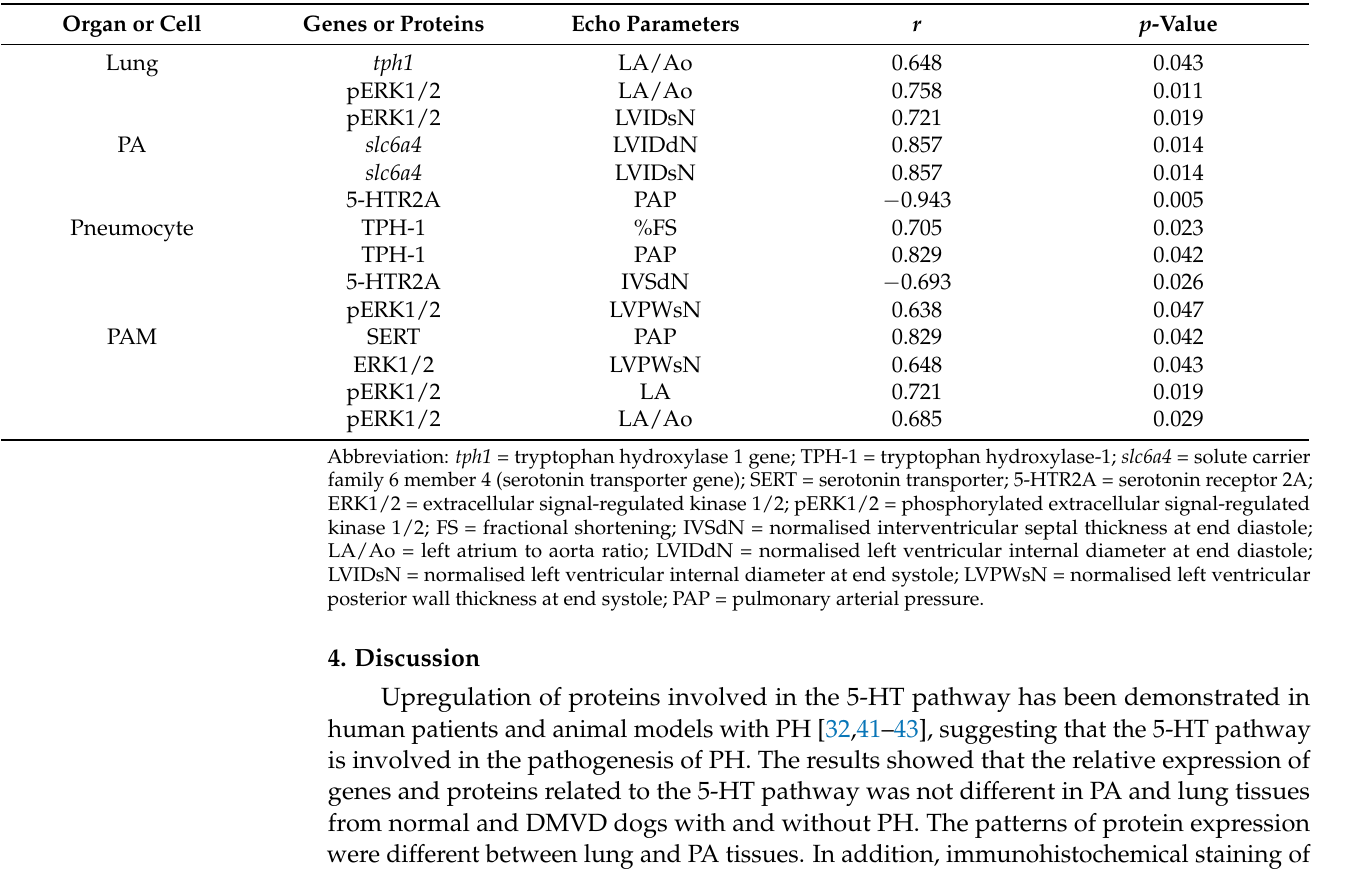
Table 7. The significant Spearman correlation between the relative expression of the targeted genes and proteins and the echocardiographic